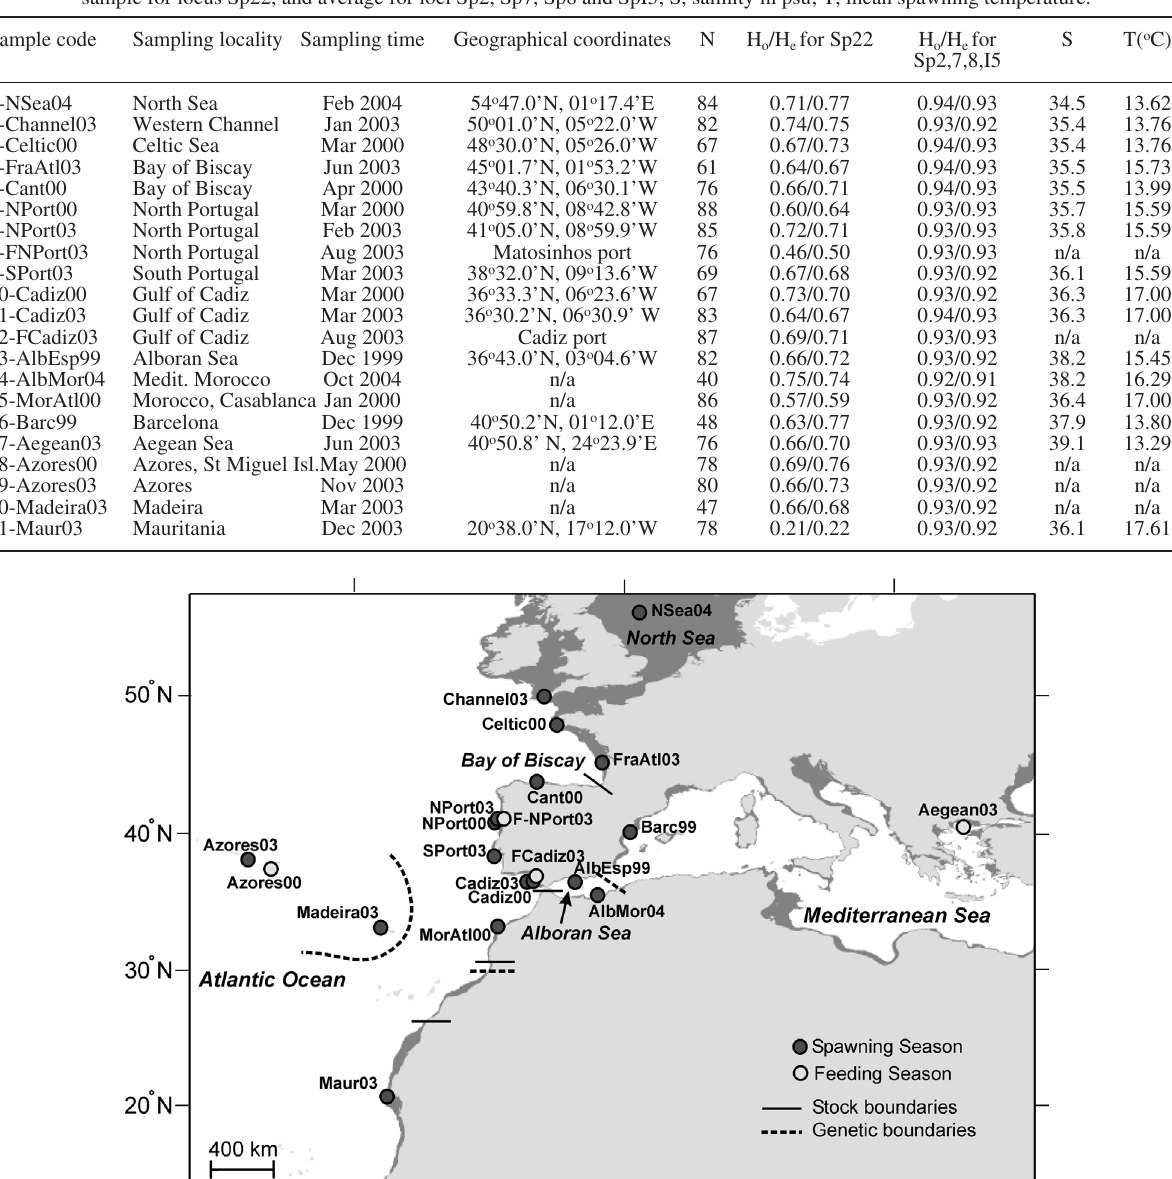
Table 1. – Information on sardine samples used in the present study. N, sample size; Ho and He, observed and expected heterozygosity per sample for locus Sp22, and average for loci Sp2, Sp7, Sp8 and SpI5; S, salinity in psu; T, mean spawning temperature. Sample code